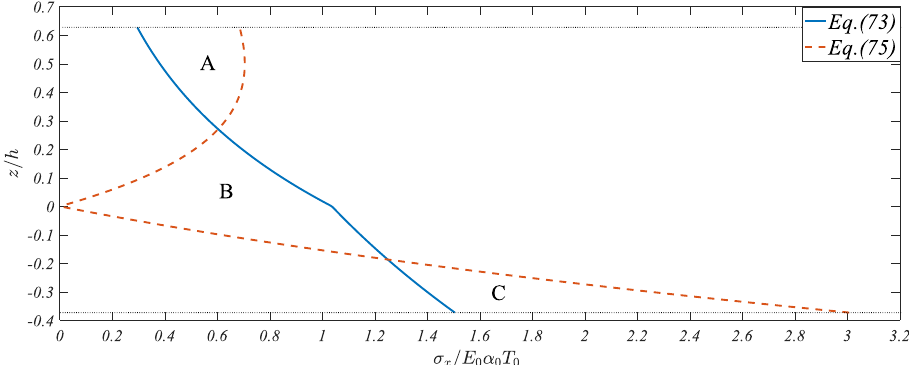
Figure 7. Axial stresses when E + ( z ) < E − ( z ), in which, a 1 = − 2, a 2 = − 1 and c = 1.